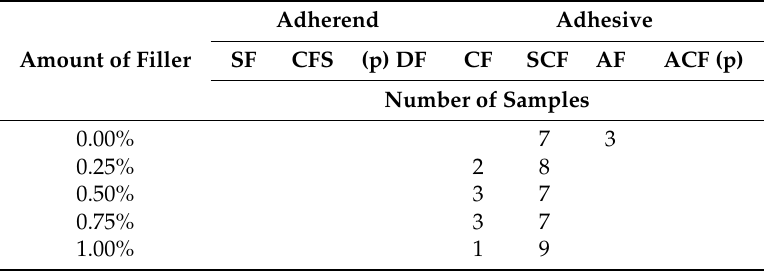
Table 5. Failure patterns evaluation according to EN ISO 10365 Standard—method I.